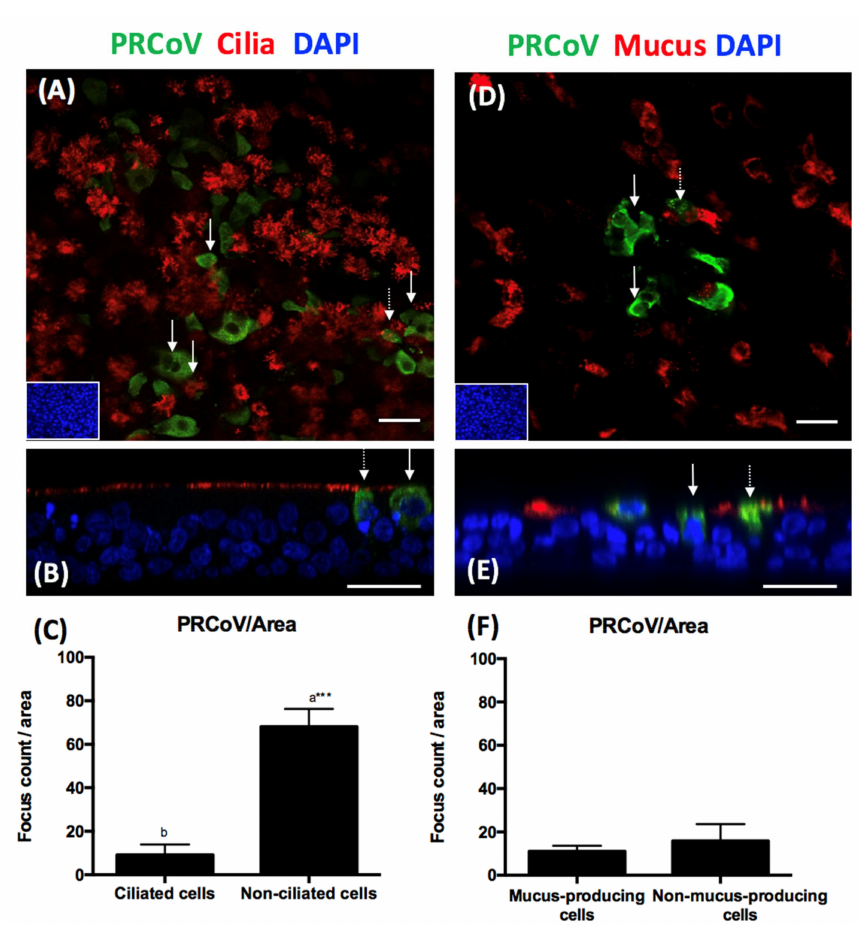
Figure 2. Tropism of PRCoV Bel85 to distinct types on well-di ff erentiated porcine tracheal epithelial cells (wdPTECs). WdPTECs were infected with PRCoV from the apical side an 6 × 10 4 FFU / ml and fixed at 1 dpi. ( A , B ) presence of PRCoV nucleocapsid (green) mainly in non-ciliated cells (solid arrow) and rarely in ciliated cells (red, dash arrow). ( C ) quantification of PRCoV antigen on the surface of ciliated cells and non-ciliated cells was calculated by ImageJ. ( D , E ) presence of PRCoV nucleocapsid (green) mainly in non-mucus-producing cells (solid arrow) and rarely in mucus-producing cells (red, dash arrow). ( F ) Quantification of PRCoV antigen on the surface of mucus-producing cells and non-mucus-producing cells was calculated by ImageJ. The results were shown as means ± SEM of six wdPTECs from three independent donors. Statistical analysis was performed by a Student’s t -test. a, b significant di ff erences between groups are indicated with di ff erent letters (*** p < 0.001). Scale bars, 25 µ m ( A , D ). Scale bars, 50 µ m ( B , E